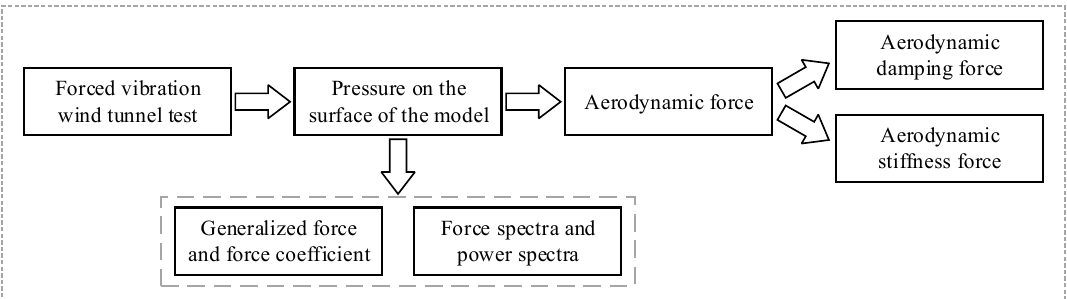
Figure 21. Calculation procedure of forced vibration wind tunnel test.